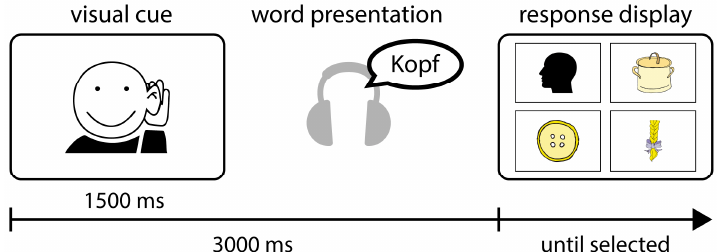
Figure 1. The experimental procedure for measuring speech perception with the word-to-picture matching task. The visual cue was displayed for 3000 ms, indicating the onset of the spoken target word presented over headphones. The target word was played over headphones 1500 ms after the onset of the visual cue. Thereafter, the response display was shown, which comprised four pictures, one representing the target word (here: Kopf (head)) and three representing phonologically similar distractor words (Topf (pot), Knopf (button), and Zopf (braid)).